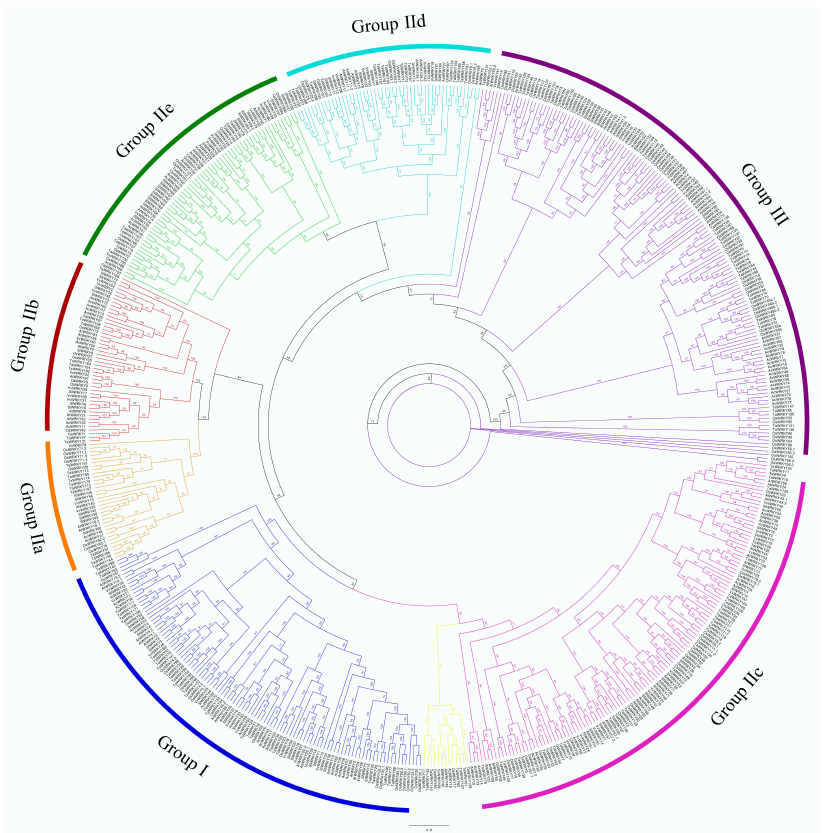
Figure 3. Neighbor-joining tree based on an alignment of 587 full-length genes encoding WRKY proteins, belonging to six plant species: Allium cepa ( AcWRKY ), Arabidopsis thaliana ( AtWRKY ), Oryza sativa ( OsWRKY ), Vitis vinifera ( VvWRKY ), Triticum aestivum ( TaWRKY ), and Solanum lycopersicum ( SlWRKY ) (for detail see Table S1). Branch lines of subtrees are colored indicating different WRKY groups and subgroups (I, IIa, IIb, IIc, IId, IIe, and